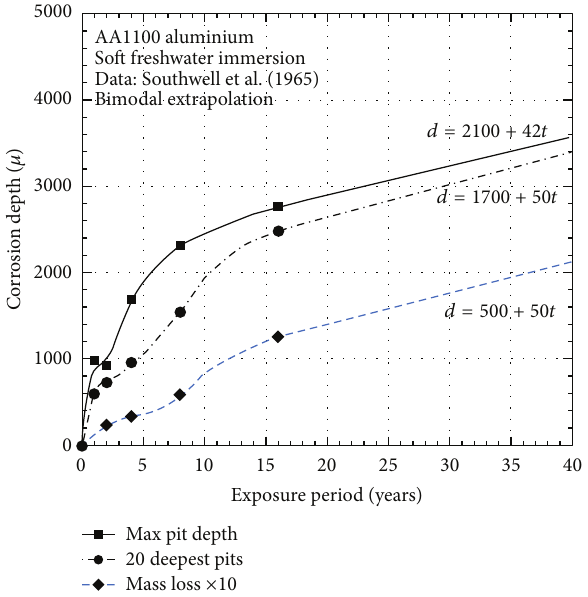
Figure 16: Data and trends for AA1100 in freshwater shown in Figure 10withthetrendcurvesextrapolatedto40years,basedonthe tangent at 16 years and the long-term trend consistent with Figure